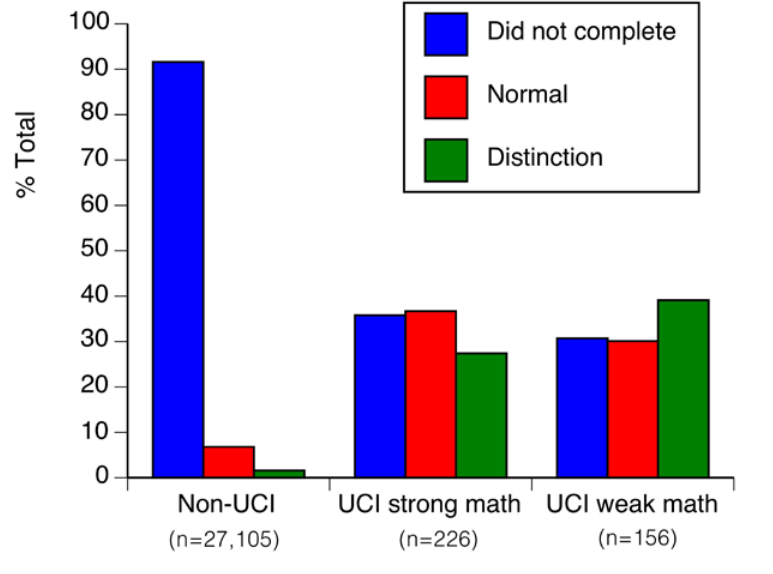
Figure 1. MOOC completion and performance by group. Percentage of total students within each group who did not complete the course, completed the course and earned a Normal certificate, or completed the course and earned a Distinction certificate. Total number in each group indicated